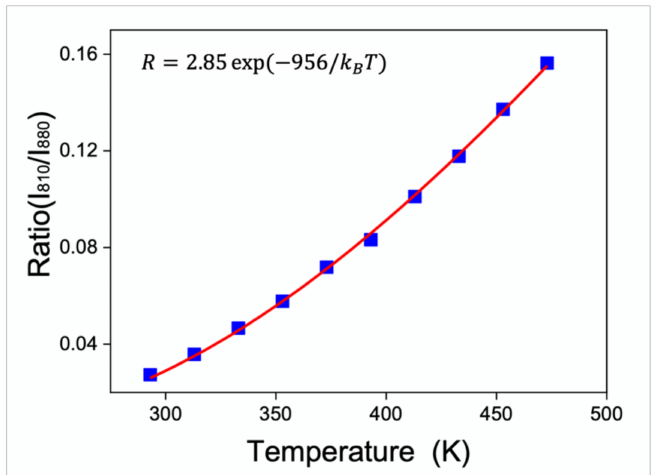
Figure 4. Experimental values of the ratio of the intensities between the thermalized bands of Nd 3+ obtained from the bulk sample inside an electrical furnace (blue squares), and fitted curve to Equation (1) (solid red